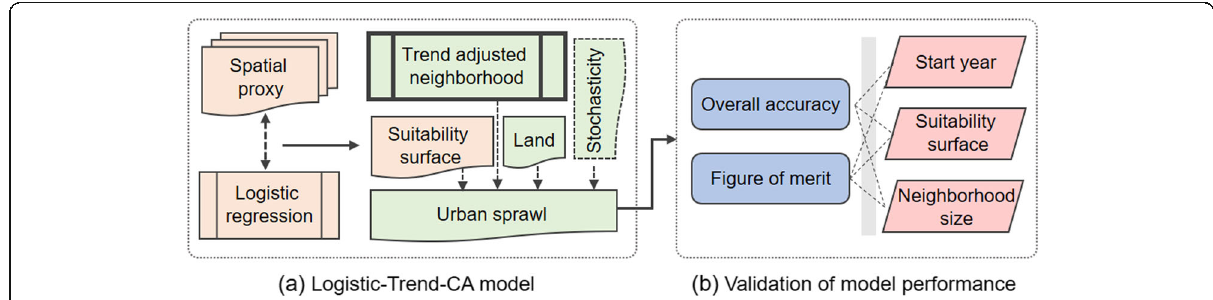
Fig. 3 The framework of the Logistic-Trend-CA model ( a ) and the validation of model performance to key factors ( b